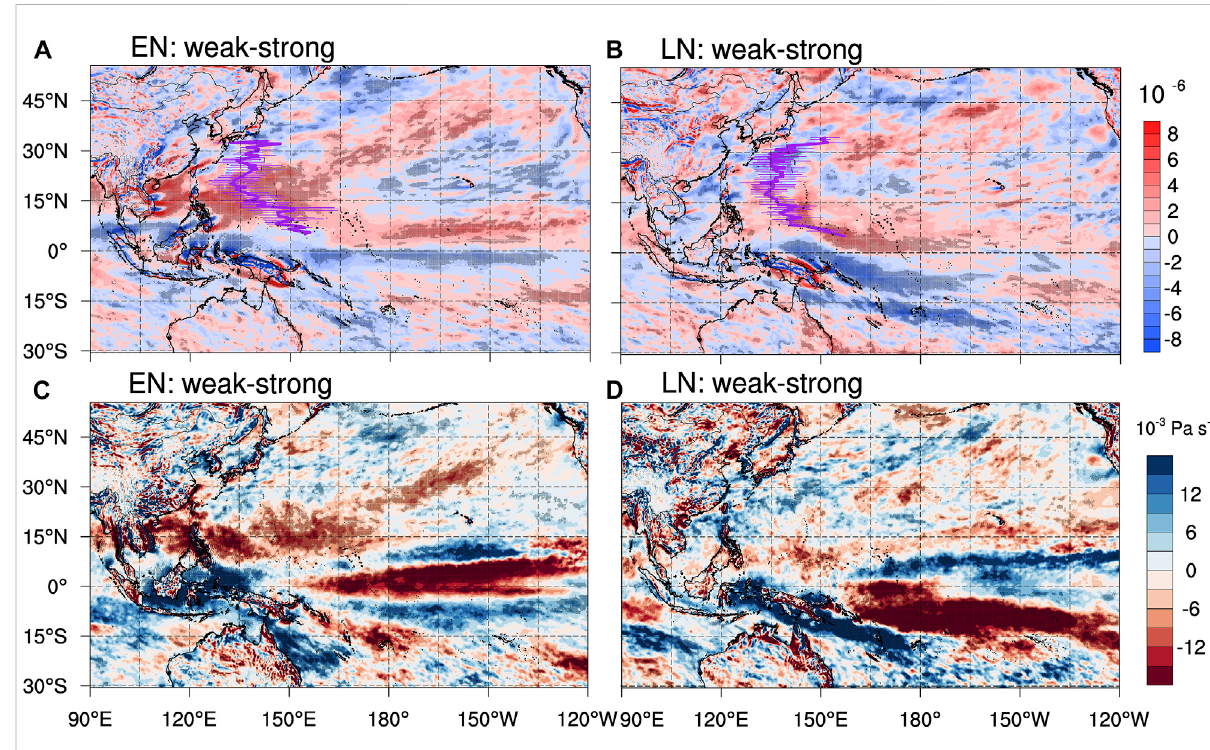
Circulation distributions, averaged during June ‒ September, at the height of 850 hPa. (A) Shading shows the environmental relative vorticity difference between the EN-weak class and the EN-strong class. The thick purple lines show the mean STY path during intensi fi cation for the two classes, and the thin purple lines show ± half the standard deviation. (C) The vertical velocity difference between the EN-weak class and the EN- strong class (the red hue shows ascending disturbance) (B,D) is the same as that in (A,C) , respectively, but for the LN-weak and LN-strong classes, respectively. Dots indicate areas of > 90% con fi dence level in Student ’ s t